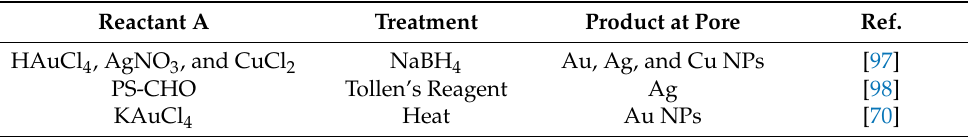
Table 1. Summary of reports for the pore-selective functionalization of HCP films with a reactant in a polymer solution and using an external agent for completion of the